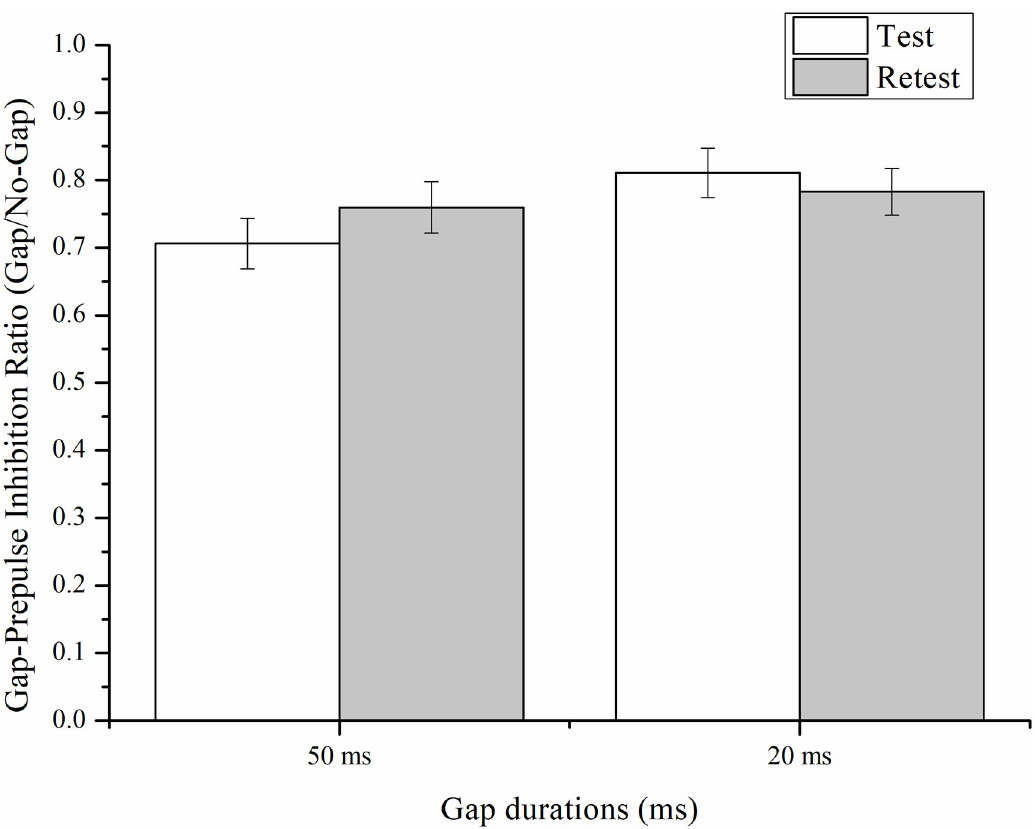
Fig 3. Gap/No-gap ratios with 50-ms and 20-ms gaps in the test and retest sessions. Error bars indicate standard error of the means